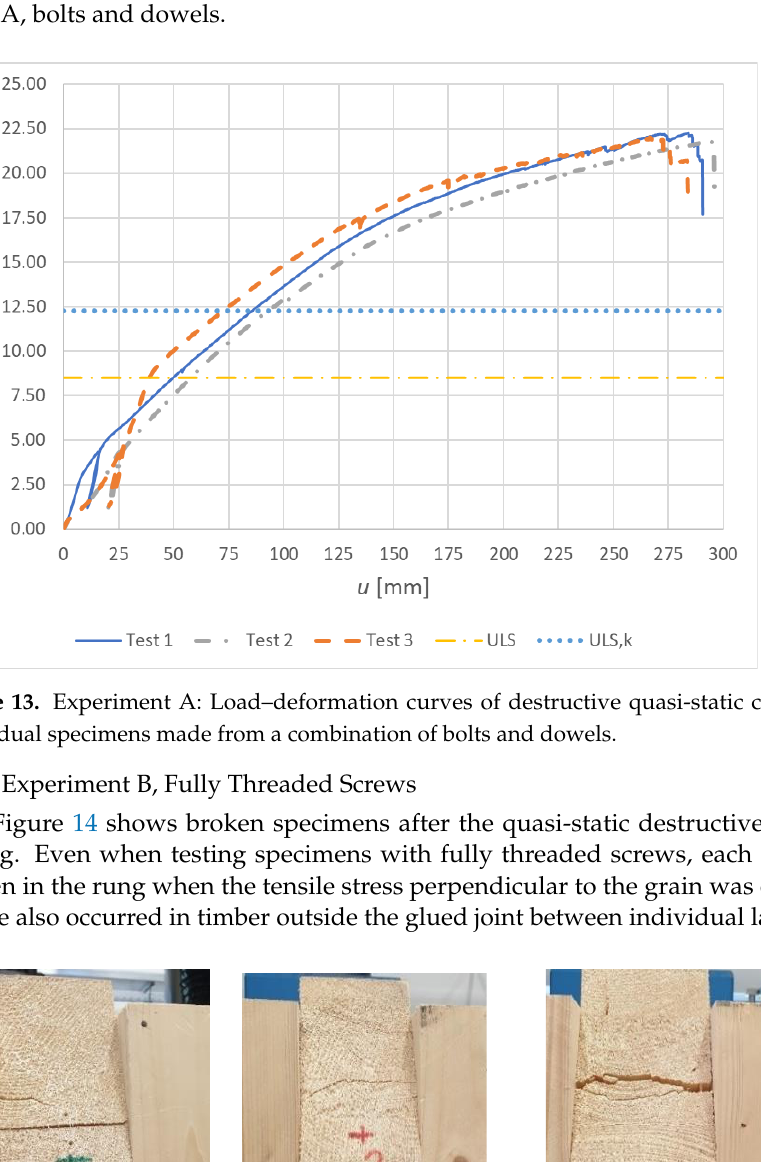
Figure 12. Experiment A, bolts and dowels: ( a ) test 1; ( b ) test 2; ( c ) test 3.